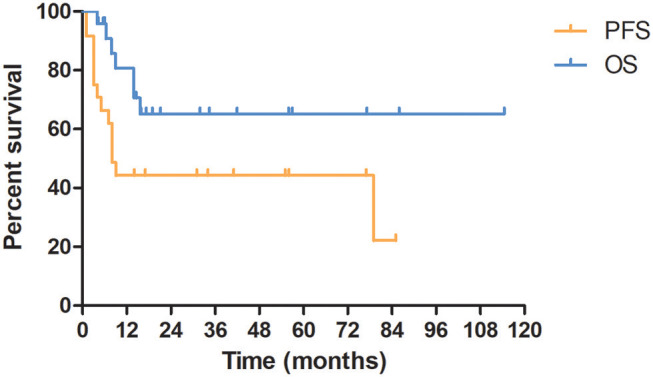
Kaplan–Meier curves of overall survival and progression free survival for all patients.